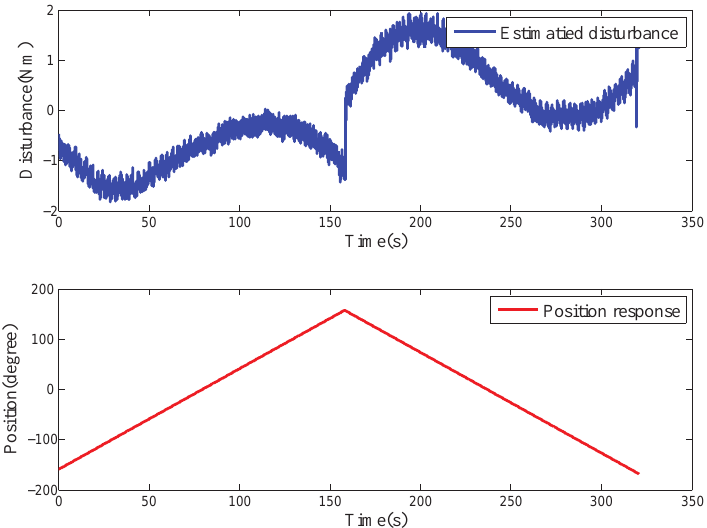
Figure 3. Diagram of triangular position response and estimated disturbance of a COP.